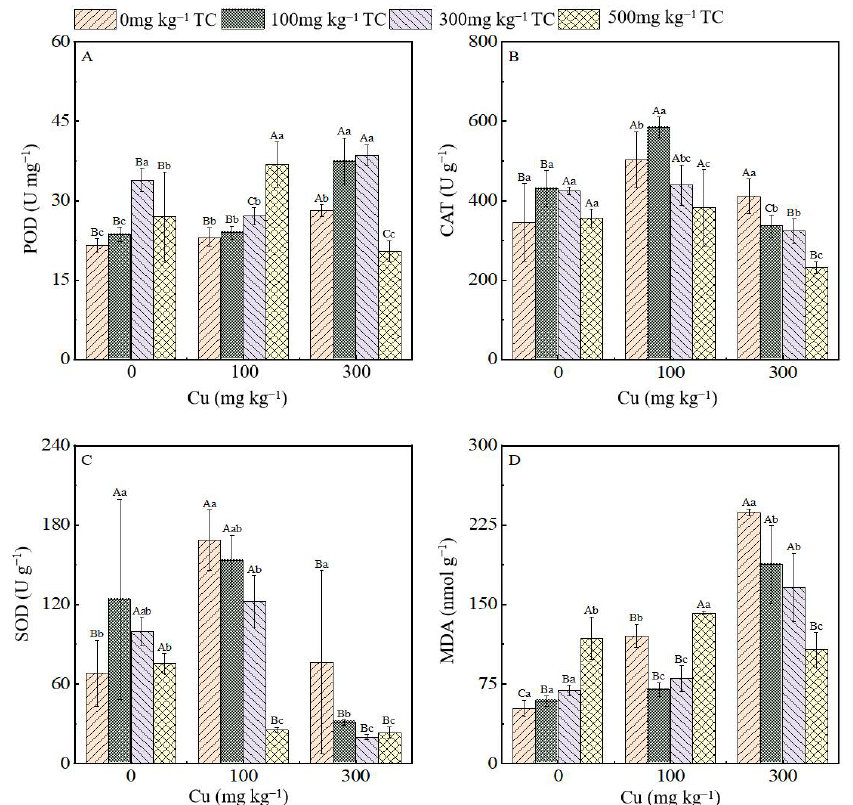
Figure 2. Impact of TC and Cu pollution on antioxidant enzyme activity and MDA of water spinach. ( A ) POD; ( B ) CAT; ( C ) SOD; ( D ) MDA. (Different capital letters indicate significant differences between different Cu treatment at p < 0.05, while different lowercase letters indicate different TC ’ s.).